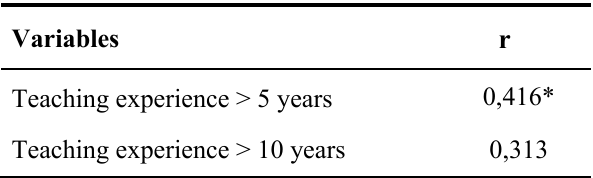
Table 3 : Correlations between students’ achievement